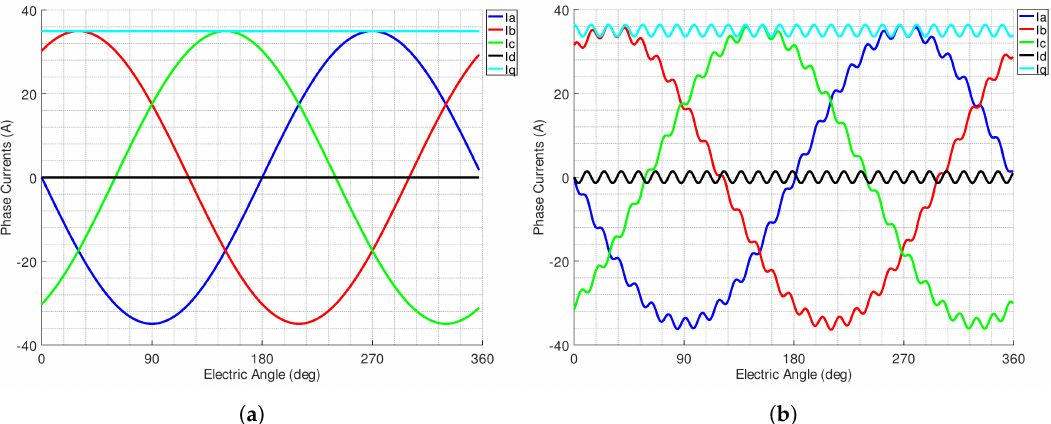
Figure 7. Finite element analysis (FEA) simulations of IPM at (cid:126) j RMS = 6.7 A RMS /mm 2 : ( a ) sinusoidal phase currents; ( b ) phase current with current ripple due to a PWM of 4